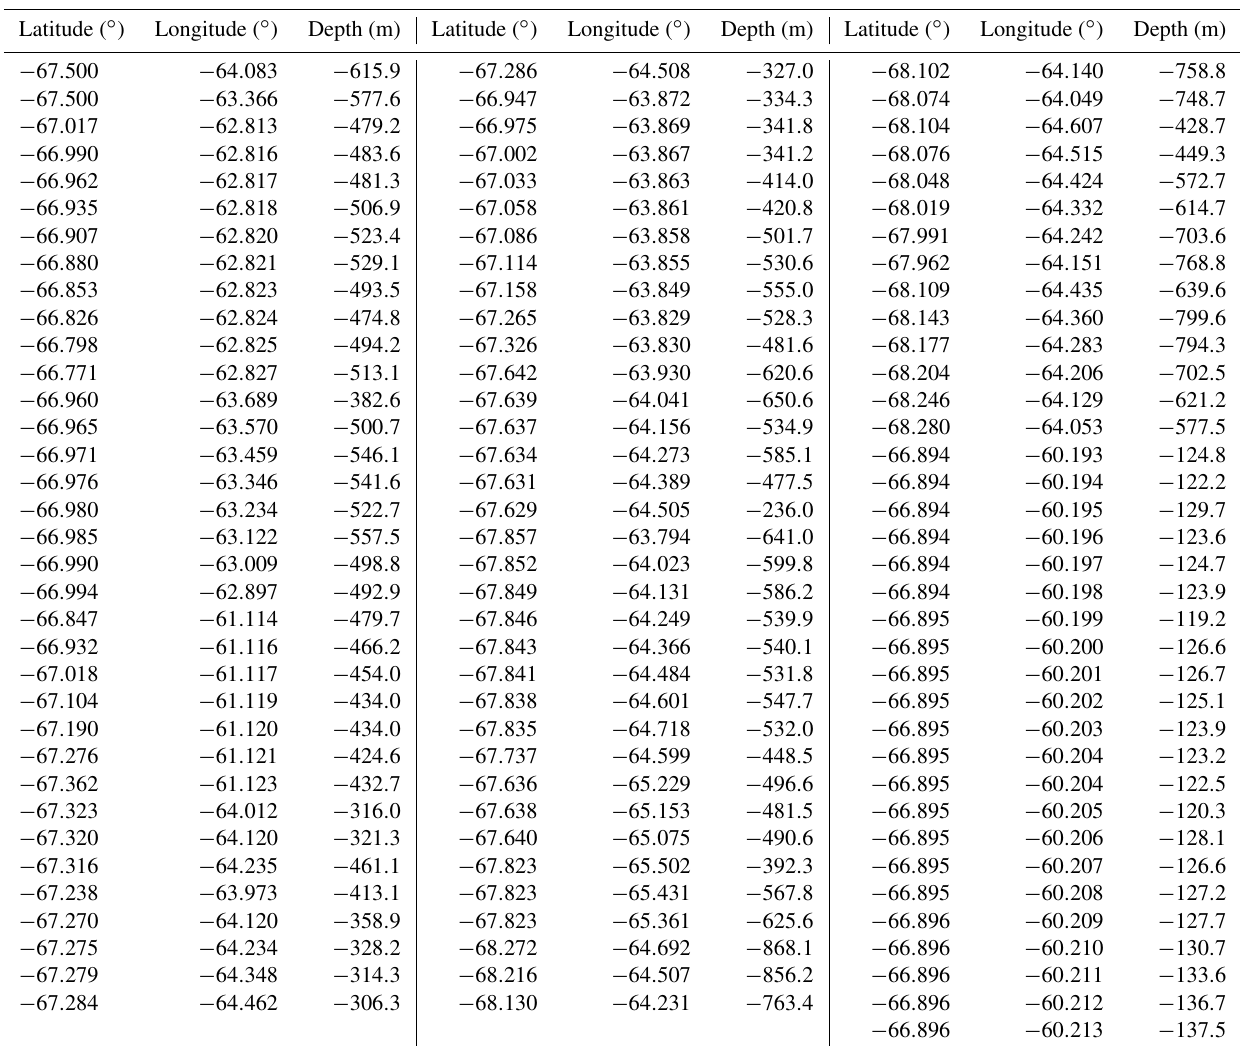
Table A1. Previously published seabed depth measurements included in the gridding process (Holland et al., 2015; Brisbourne et al.,